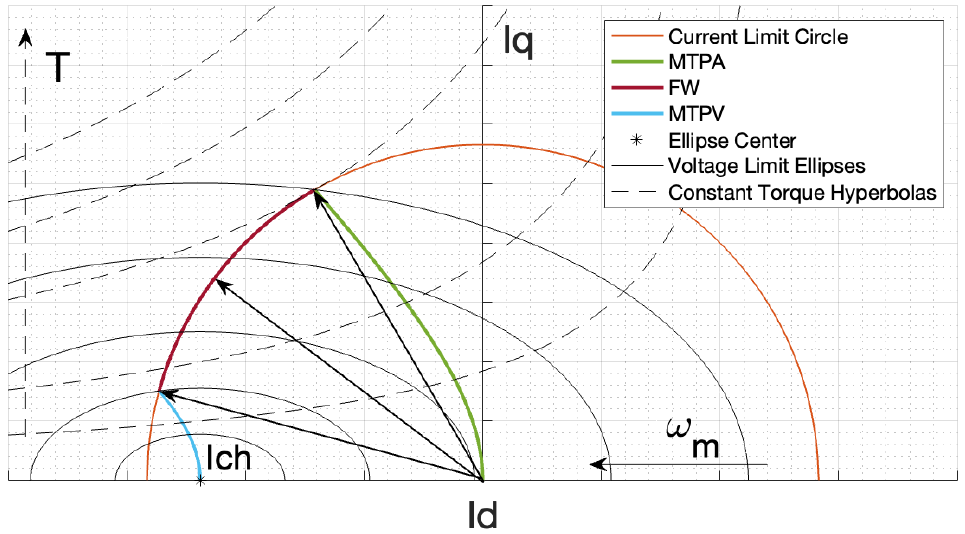
Figure 1. MTPA, FW and MTPV trajectories on d-q reference